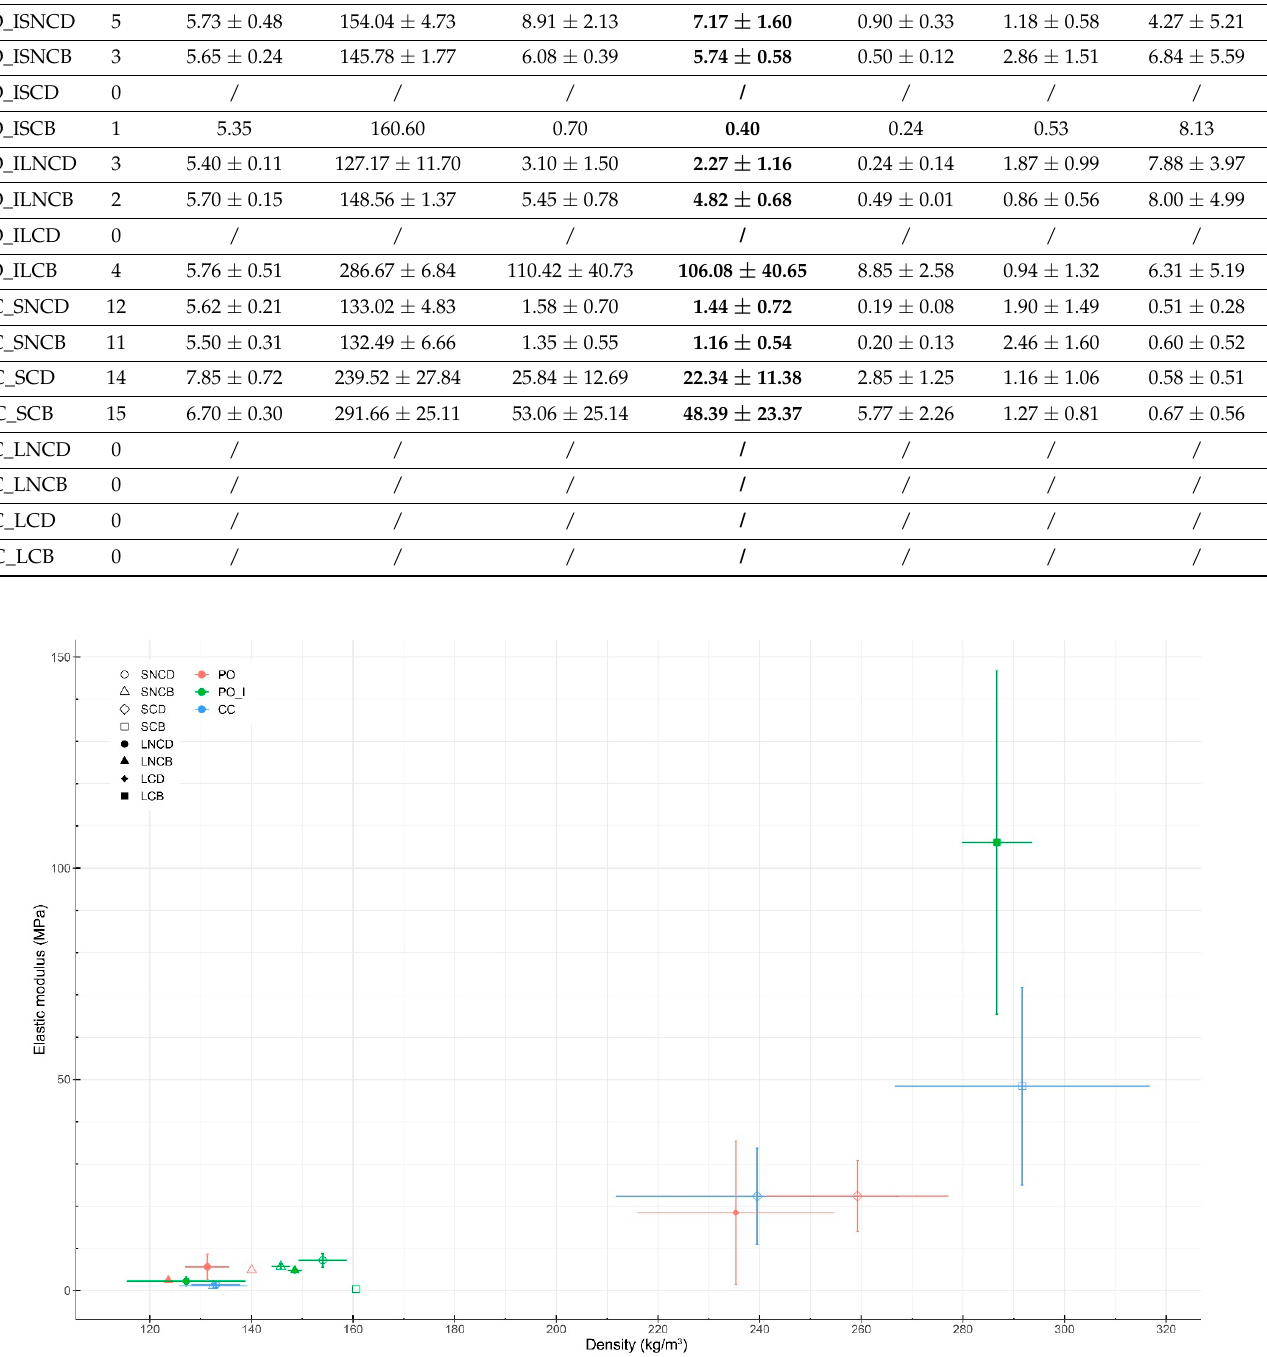
( d ) Figure 7. This figure shows the deformation of a PO_LNCB specimen throughout the bending test: ( a ) beginning of the test; ( b ) after 6 min and 25 s; ( c ) after 13 min (just before the end of the test). ( d ) shows the asymmetric deformation of a different specimen from the PO_LCD sample after 3 min.